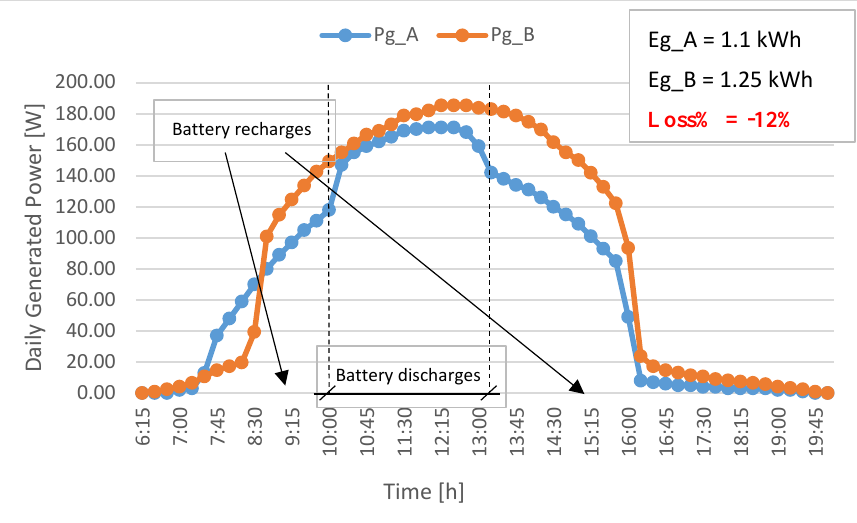
Figure 16. Daily Power generation curves, Pg_A and Pg_B, of the two prototypal PV-generators A 492 Figure 16. Daily power generation curves, Pg_A and Pg_B, of the two prototypal PV generators A and B, on an August 2021 cloudless day together with the corresponding daily generated energy 493 and B, on an August 2021 cloudless day, together with the corresponding daily generated energy values, Eg_A and Eg_B and the percentage loss factor, Loss%, of the PV-Generator A with respect to 494 values, Eg_A and Eg_B, and the percentage loss factor, Loss%, of the PV generator A compared with the PV-Generator B. In this experiment, the three PV-cells of the homemade sub-modules of the PV- 495 the PV generator B. In this experiment, the three PV cells of the homemade submodules of the PV generator A are again shaded and the battery control unit is activated, while the PV-generator B is 496 generator A are again shaded, and the battery control unit is activated, while the PV generator B is now completely unshaded. 497 now completely unshaded.